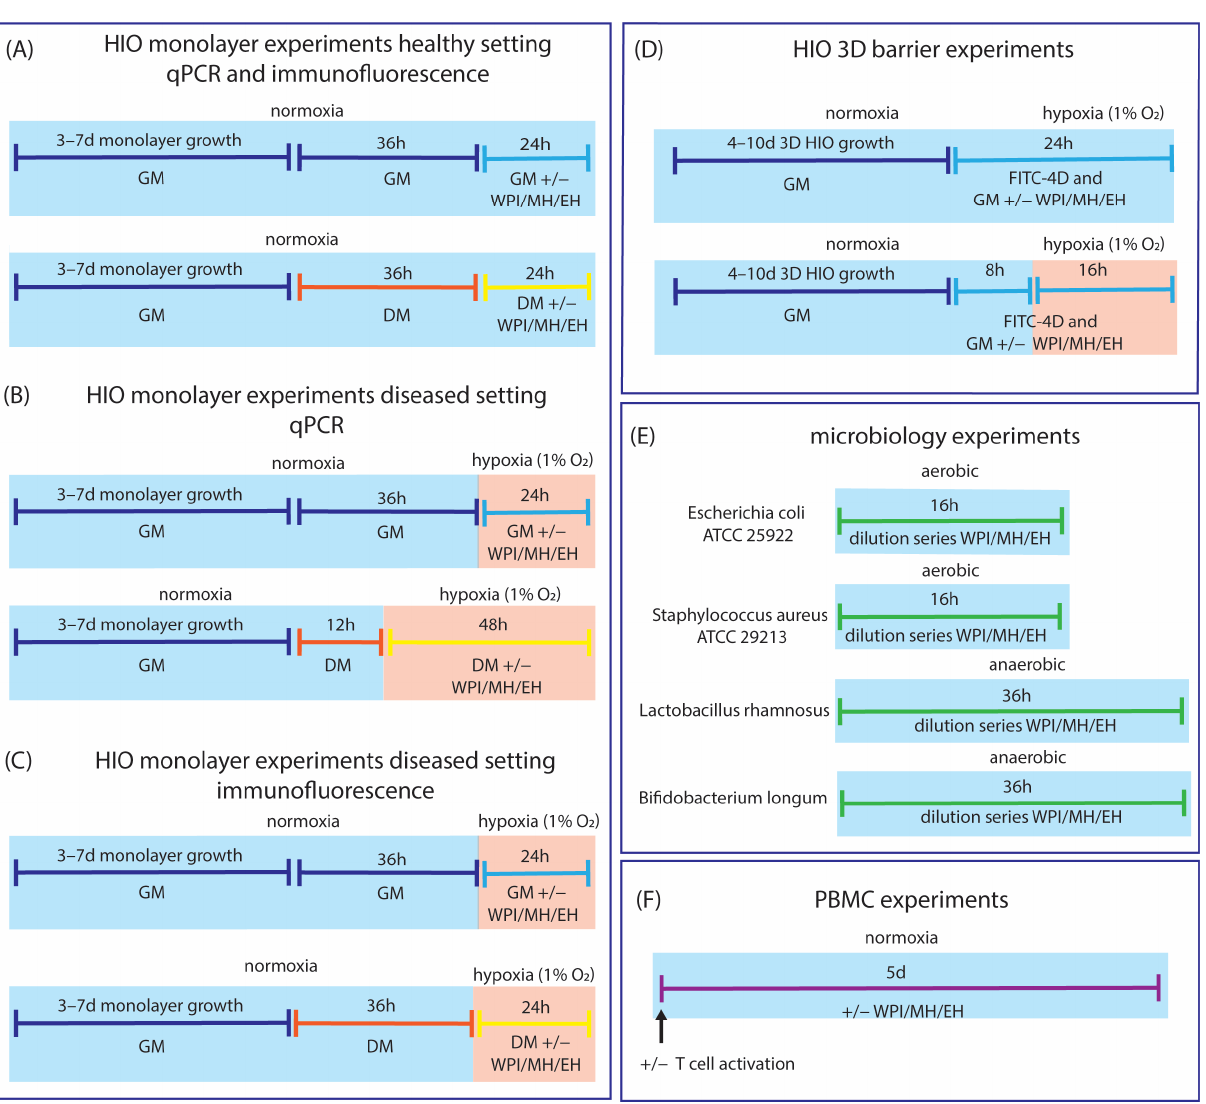
GM with or without added WPI, DH28, or DH51. Villus-like organoids were cultured with DM for 12 h and subsequently for 48 h in a hypoxic incubator (1% O 2 ) with DM with or without added WPI, DH28, or DH51. ( C ) For HIO monolayer experiments in a diseased setting (hypoxia) analyzed by immunofluorescence staining, HIO monolayers were cultured for 3–7 d prior to the onset of the experiment. At start of experiment, crypt-like-organoids were cultured with GM for 36 h, followed